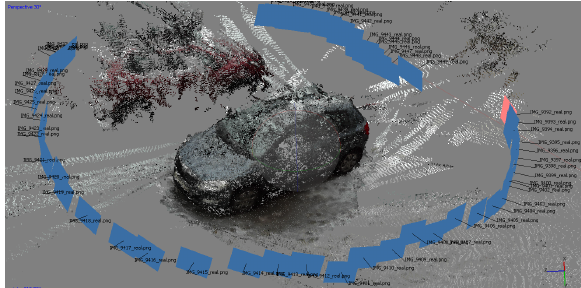
Figure 4. Dense point cloud with the visible texture